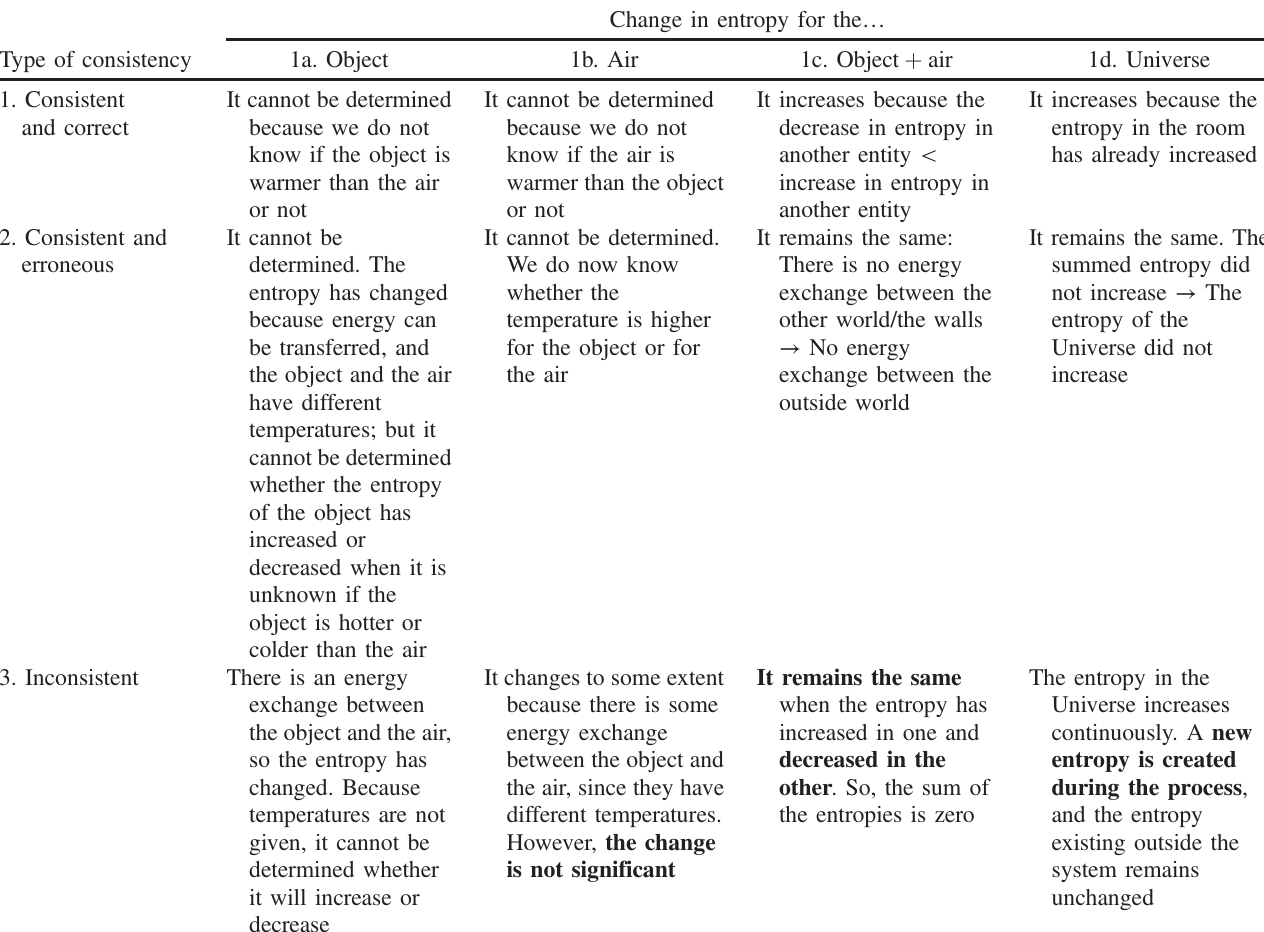
TABLE II. Sample quotes of the different types of responses in terms of their consistency within the four items (1a – 1d) concerned with changes in macroscopic entropy. Two types (correct and erroneous) of consistent sets of answers and one set of inconsistent answers are provided. The inconsistency is in boldface in the last